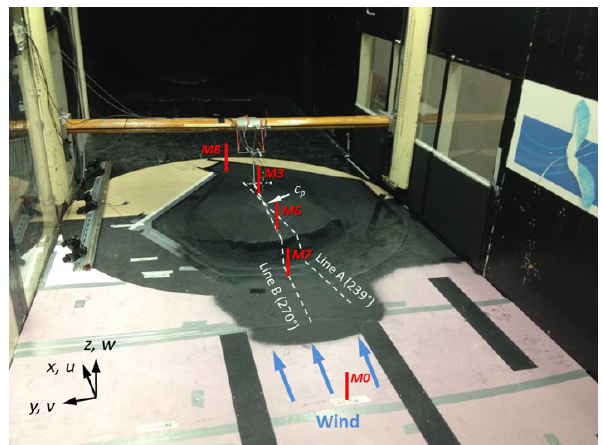
Figure 3. Photograph of the BLWTL experimental